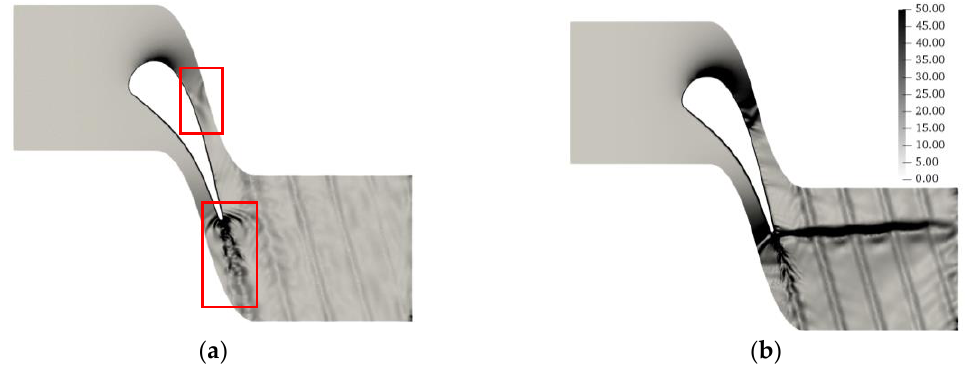
Figure 4. Instantaneous contours of the normalized density gradient | ▽ ρ |/ ρ : ( a ) MUR129_ SAS; ( b ) MUR241_ SAS .